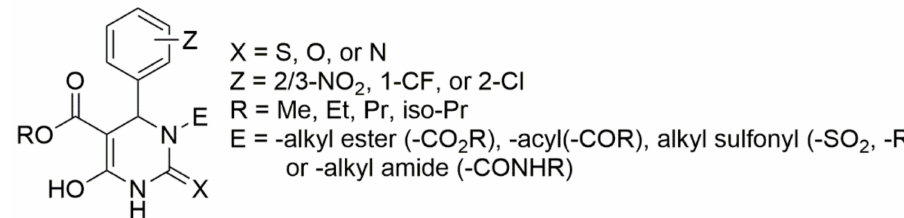
Figure 3. Some of the DHPMs initially tested for their antihypertensive activity: ( 1 ) nifedipine; ( 2 )–( 7 ) analogues of nifedipine.